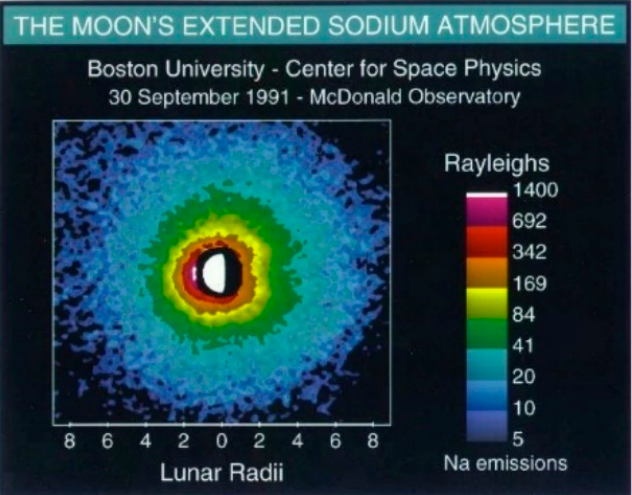
Figure 4. Glow from sodium in the lunar atmosphere.